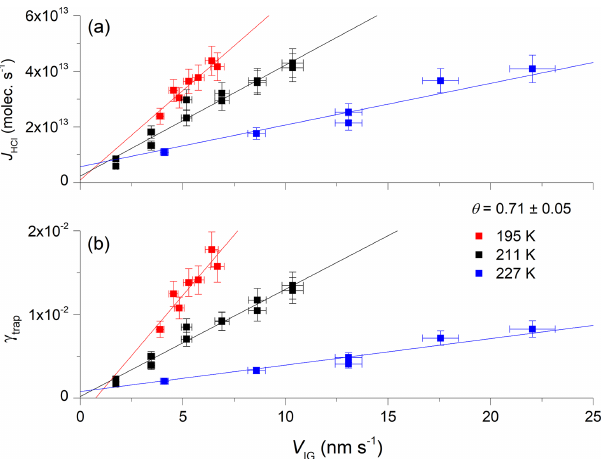
Figure 4. Dependence of the trapping coefficient, γ trap , on the ice growth velocity ( V IG ) at three different temperatures and a compa- rable equilibrium surface coverage ( θ ) of HCl. The solid, straight lines are least-squares fits to the data. The error bars represent total uncertainty in γ trap and the ice growth